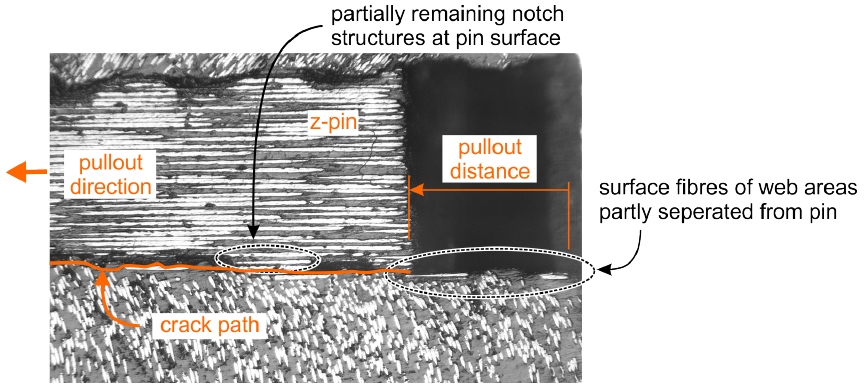
Figure 6. Partially pulled-out pin with circumferential notches with sinusoidal notch design; crack path is marked and remaining notch structure can be observed at z-pin surface and in the